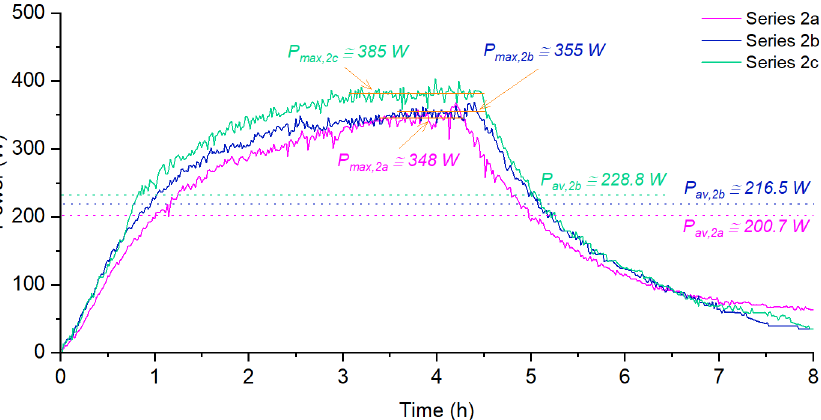
Figure 10. Variations in the power transferred from the SAH to the ventilation air when the SAH operated as a solar chimney and airflow was set to 100 m 3 /h (Series 2a), 150 m 3 /h (Series 2b), and 200 m 3 /h (Series 2c). Table 8. Summarization of the power transferred from the SAH to the ventilation air when the SAH operated as a solar chimney and airflow was set to 100 m 3 /h (Series 2a), 150 m 3 /h (Series 2b), and 200 m 3 /h (Series 2c).